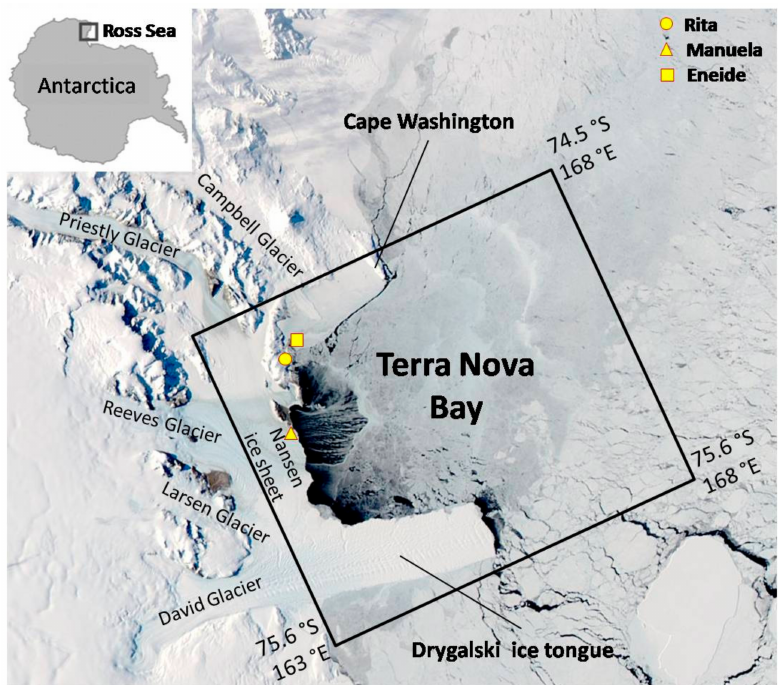
Figure 1. Terra Nova Bay (Ross Sea, Antarctica) as captured by MODIS on NASA’s Aqua satellite on 16 October 2007, courtesy of NASA MODIS Rapid Response Team, Goddard Space Flight Center, Greenbelt, MD, USA. The black rectangle defines the study area where the polynya extent is estimated. AWS locations are identified through geometric